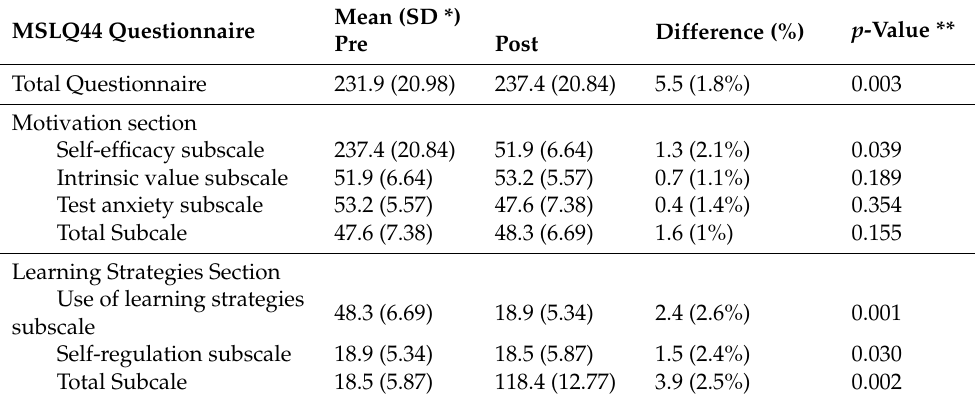
Table 3. Average scores for MSLQ44 questionnaire pre- and post-simulation (mean (SD)) and difference between measurements (% of the maximum score) ( n =